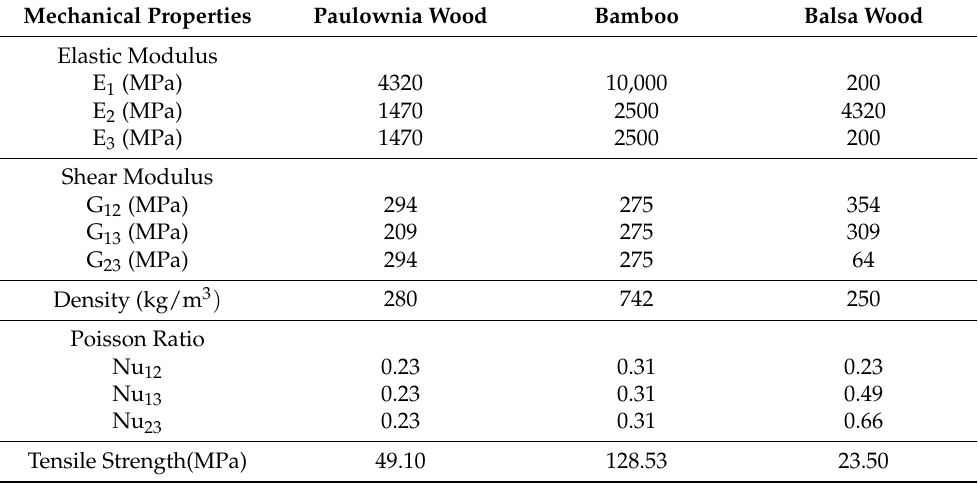
Table 2. Properties of materials used in the core of bridge [39–44]. Mechanical Properties